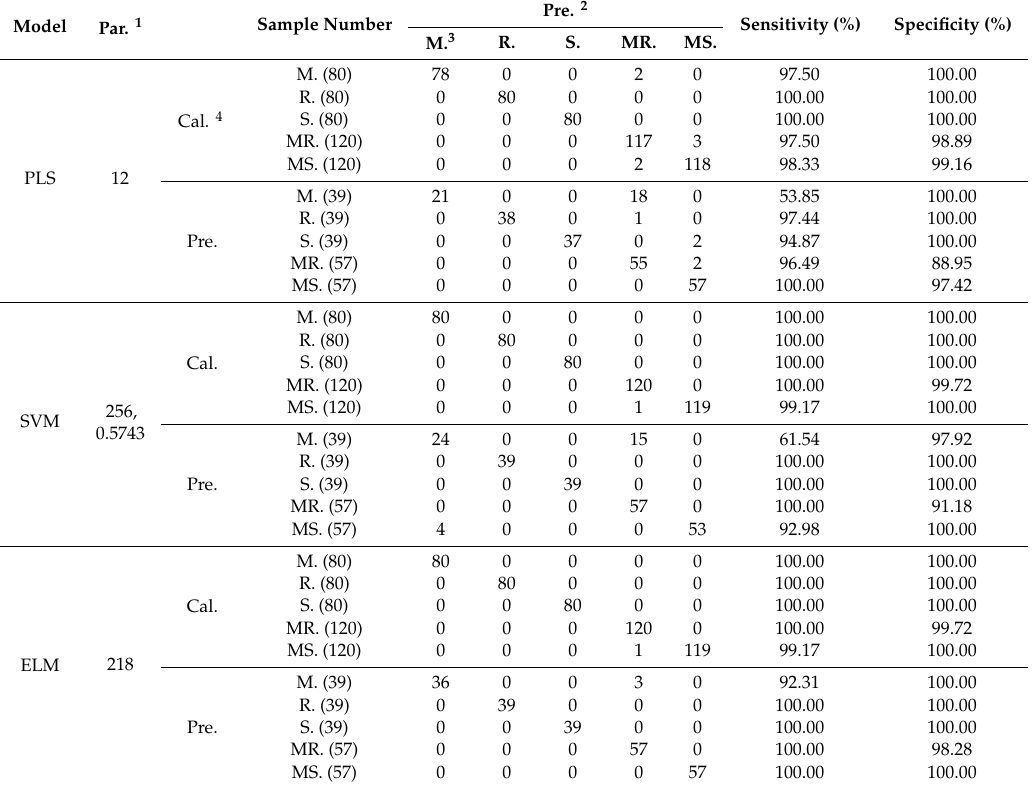
Table 4. Confusion matrix of models using optimal